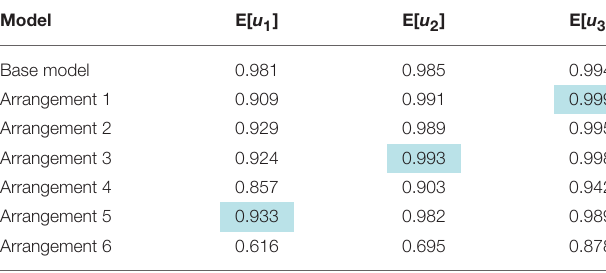
The highlighted row indicates the risk-optimal arrangement for each utility